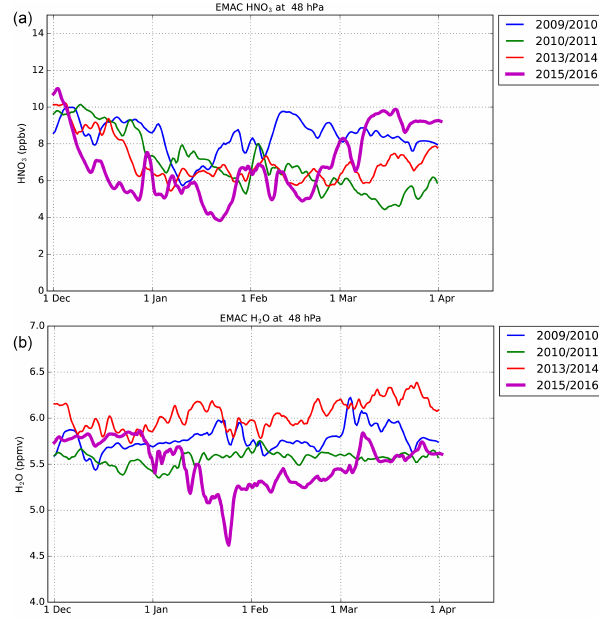
Figure 11. Tracer time series of HNO 3 (a) and H 2 O (b) for the 2009/2010 (blue), 2010/2011 (green), 2013/2014 (red) and 2015/2016 (magenta) Arctic winters at 48hPa, averaged over 70– 90 ◦ N (results from the T42L90 simulation are shown